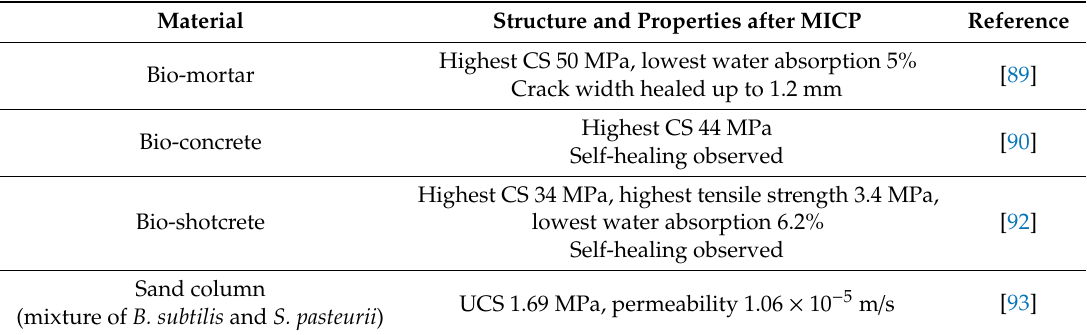
Table 5. Materials produced using MICP with Bacillus